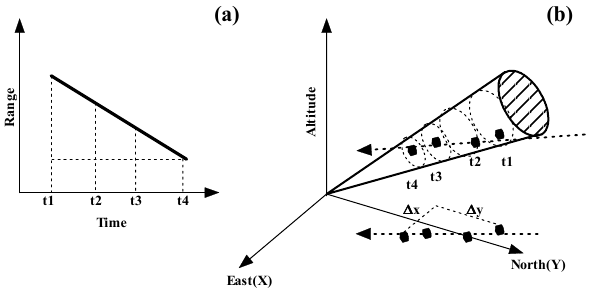
Fig. 6. ( a ) A sketch of an ideal striation in the range time plot. ( b ) Simple geometry of an ideal striation by tracing an isolated echo- ing region with a constant velocity at a fixed altitude, which would result in the range–time variation in (a).